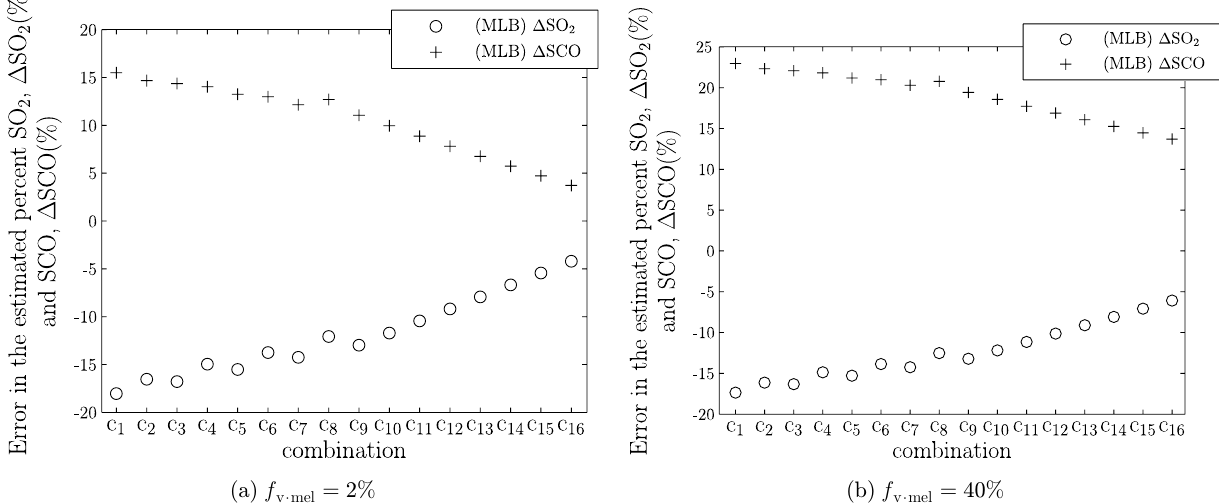
Fig. 2. Error in blood OxyHb saturation ( (cid:1)SO 2 ) and blood COHb saturation ( (cid:1)SCO ) given by MLB for di®erent combinations of SO 2 and SCO in Table 1 and when volume fraction of melanosomes ( f v (cid:3) mel ) is (a) 2 % and (b) 40 % .